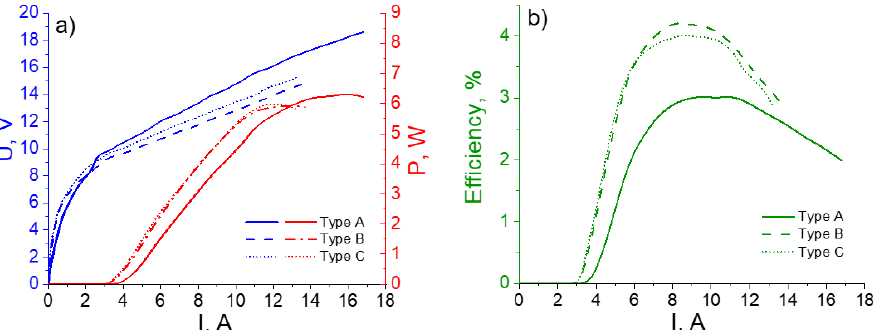
Figure 2. The L(I) and V(I) ( a ) and efficiency ( b ) curves measured for the lasers based on the three types of heterostructures. The details on the latter are shown in Table 1. The QCLs of Type C and Type B demonstrated lower threshold characteristics and better efficiencies. However the peak power was the highest for the Type A QCL due to the better thermoconductivity of the upper